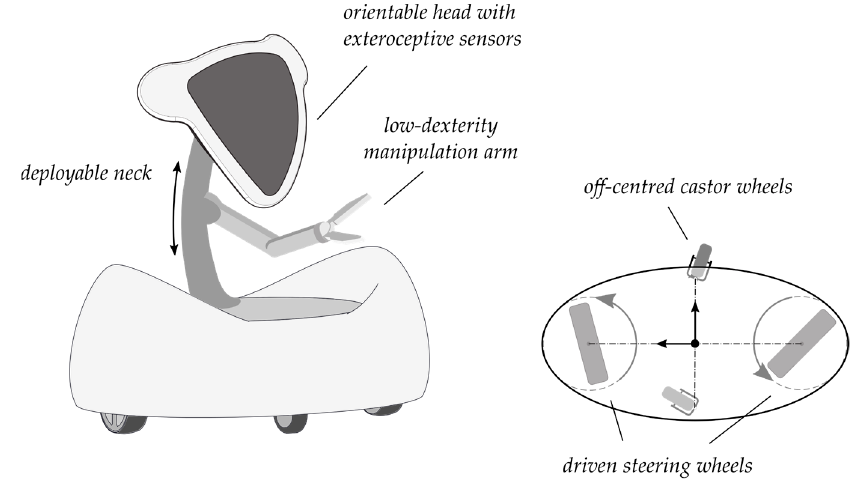
Figure 1. Preliminary conceptual design of the PAQUITOP robot.